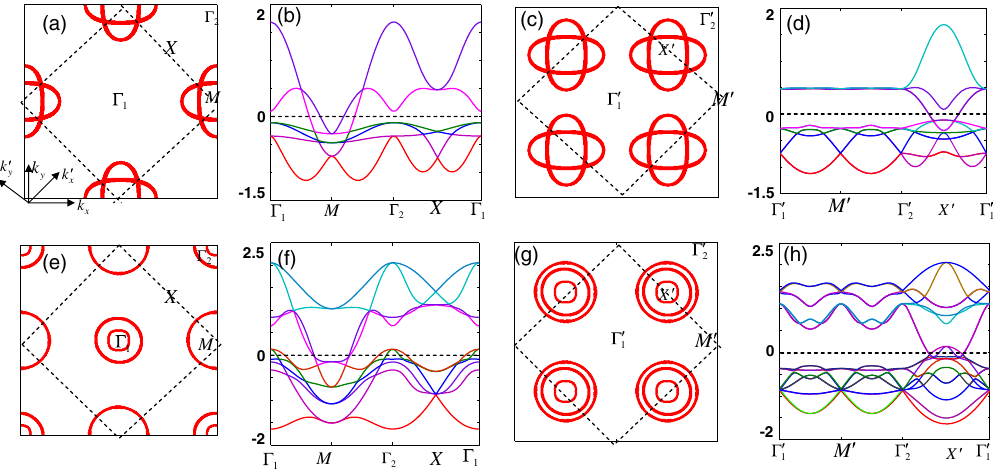
FIG. 2. Three-orbital [30] and five-orbital [10] models: (a),(e) The Fermi surfaces; (b),(f) the band dispersion along the high-symmetry lines; (c),(g) the Fermi surfaces after the gauge transformation; (d),(h) the band dispersions along the high-symmetry lines after the gauge transformation. The hopping parameters can be found in the two references. The y axis for (b),(d),(f),(h) is in units of